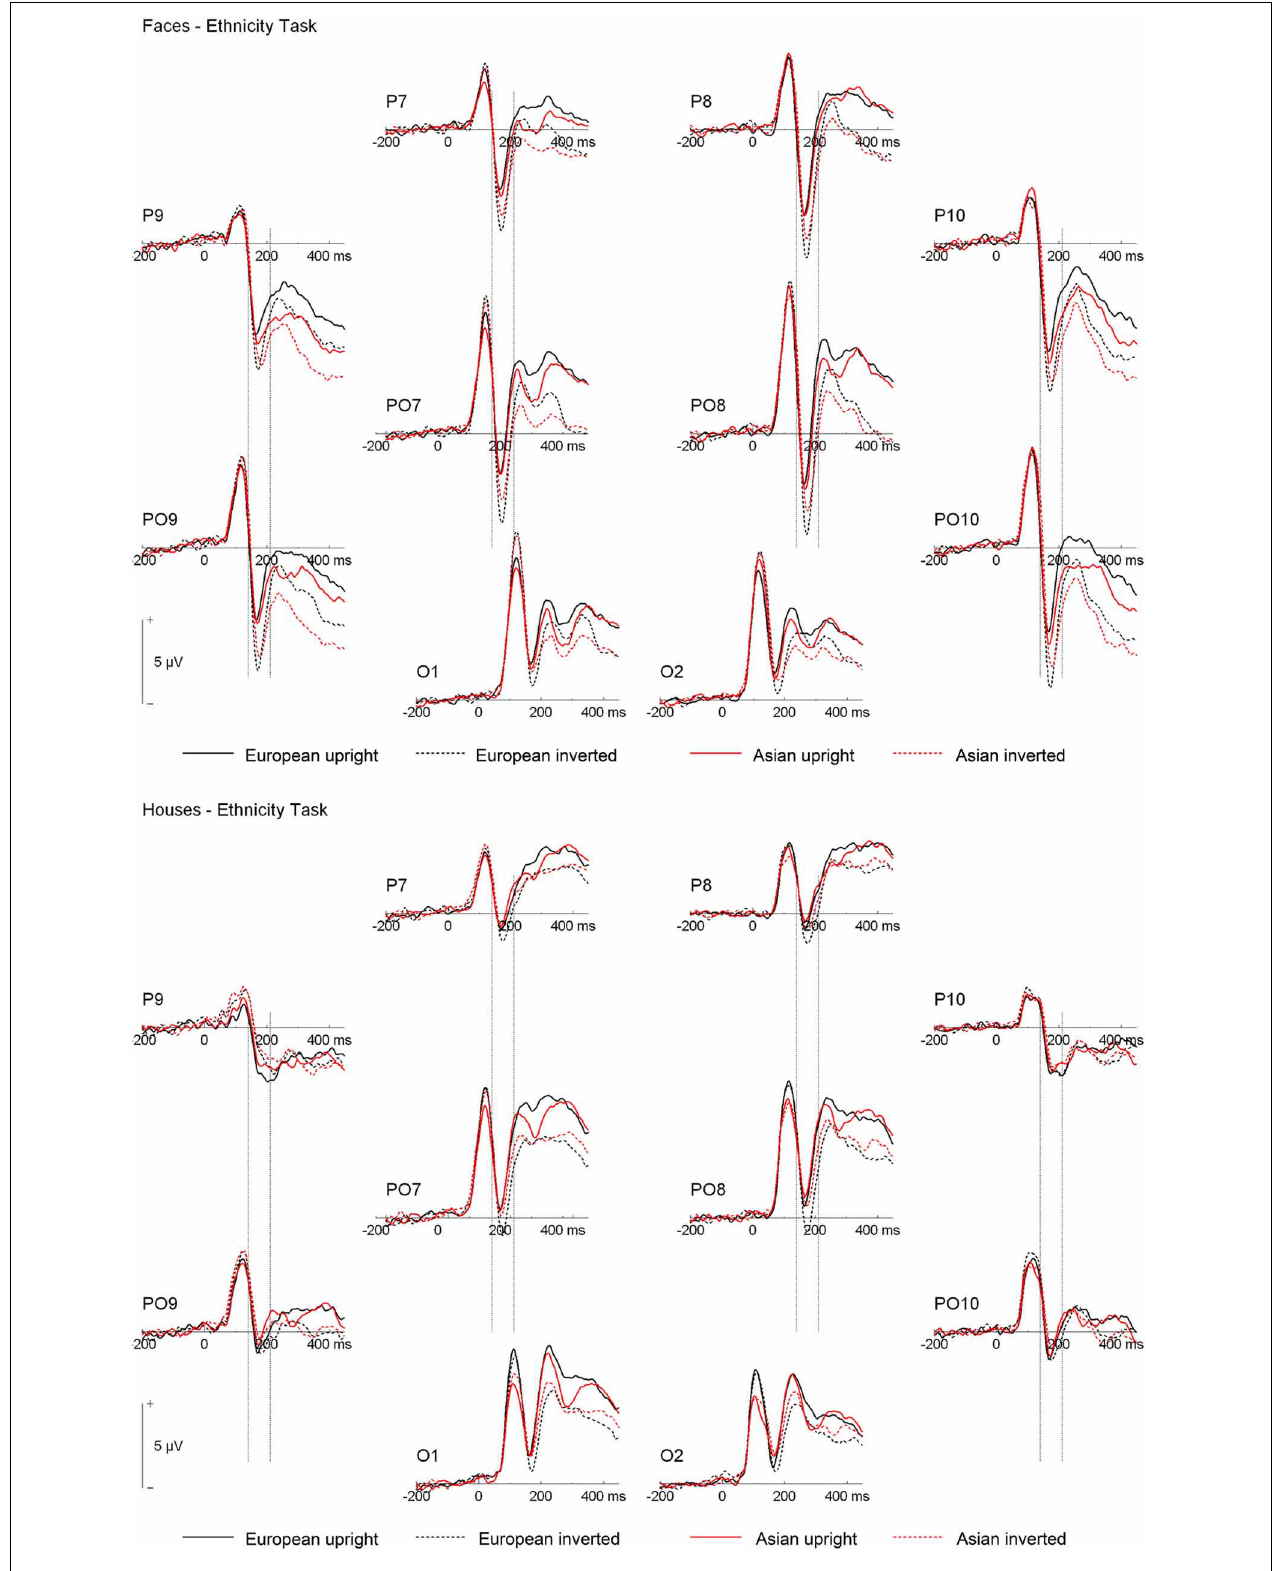
FIGURE 2 | Grand mean ERPs from the ethnicity task. Vertical lines indicate the N170 time window.